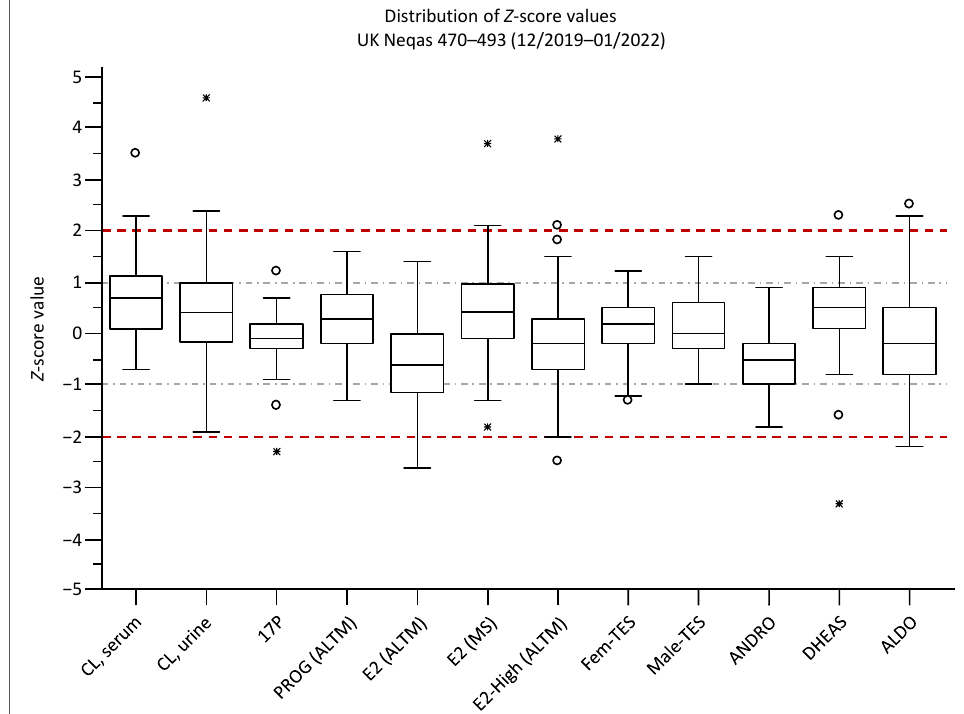
Figure 3. Boxplots showing distribution of Z -score values for included parameters of the UK NEQAS scheme for steroids. 1 Z = one SD of the group mean. LC-MS group mean as official target for 17-OH-progesterone (17P), androstenedione (ANDRO), aldosterone (ALDO), cortisol (CL), dehydroepiandrosterone sulfate (DHEAS), estradiol (E2), progesterone (PROG), and testosterone (TES). TES testing is split up in a scheme for samples from females (Fem-TES) and males (Male-TES). E2 testing is split up in regular samples (E2) and samples from E2 substitution (E2-High). All-methods-trimmed mean (ALTM) as official target for PROG and E2. LC-MS group mean (MS) available for E2. Too few LC-MS participants for LC-MS group statistics for PROG and E2-High. Sample numbers per analyte ranged from 52 to 80 (see Table S7 for details). The box of the boxplot ranges from the 1st to the 3rd quartile (interquartile range (IQR), 25th to 75th percentile), with the horizontal line indicating the median (50 th percentile). Whiskers are positioned at the highest/ lowest data point within the ±1.5-fold distance of the IQR. Circles indicate data points in the value range between the ±1.5-fold and ±3.0-fold IQR, stars indicate data points exceeding the ±3.0-fold IQR. For the PROG, the E2-High (high target levels), and the E2 proficiency testing schemes,